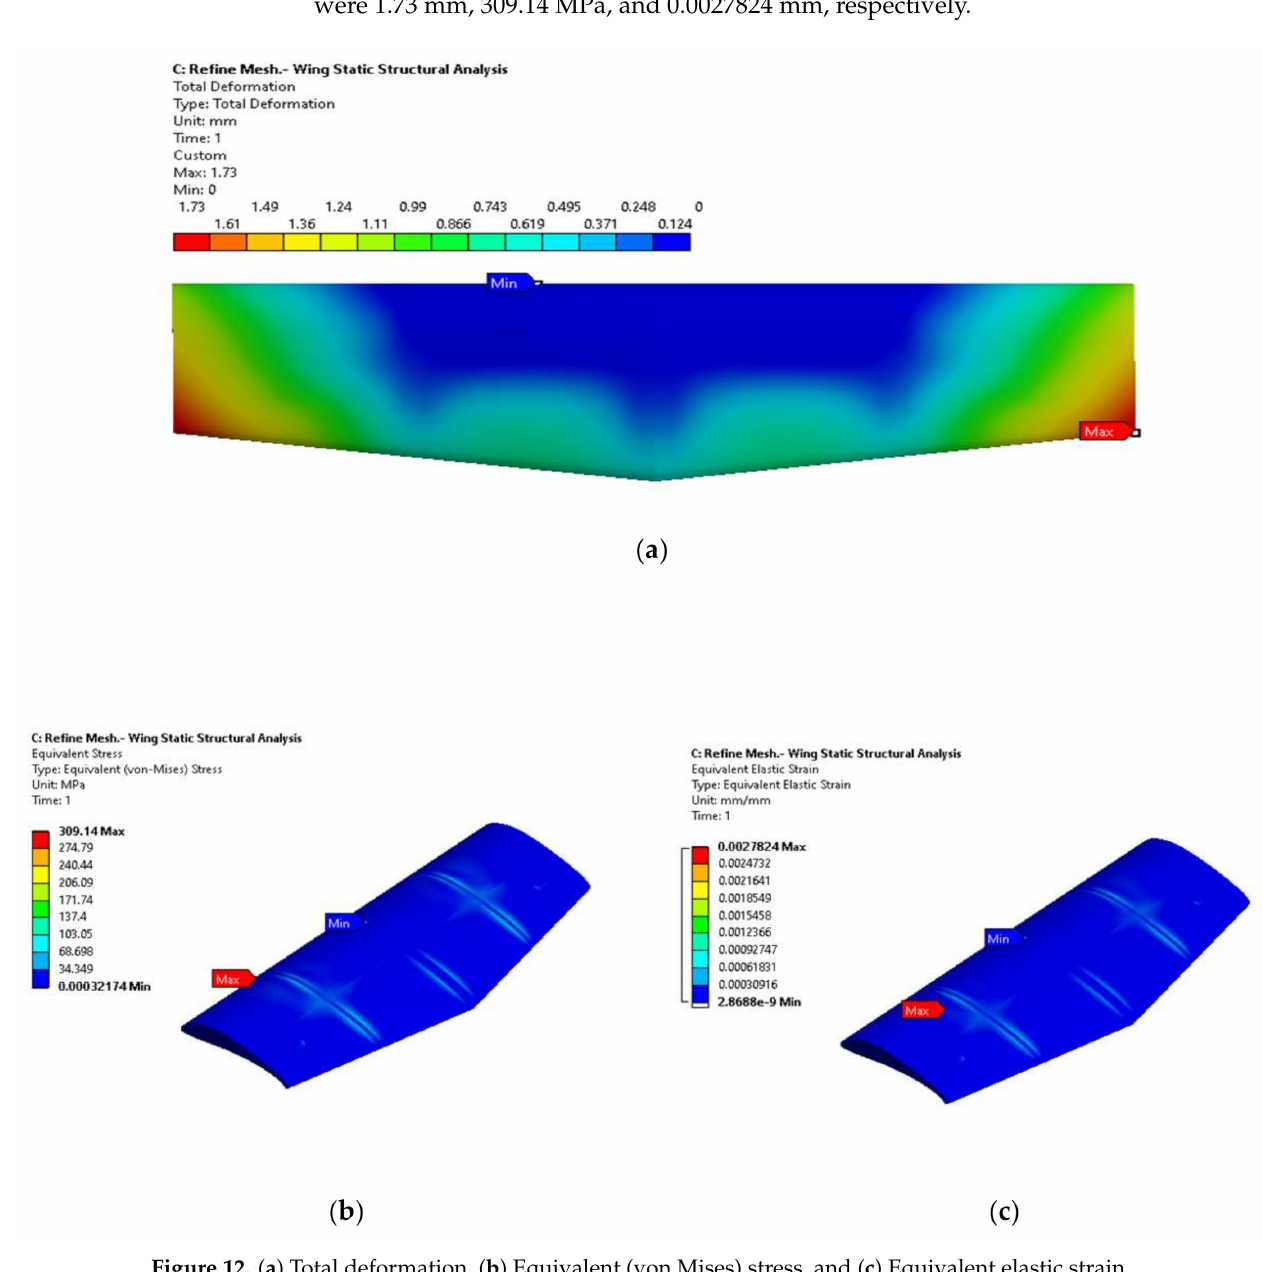
Figure 12. ( a ) Total deformation, ( b ) Equivalent (von Mises) stress, and ( c ) Equivalent elastic strain. Table 4. Maximum deformation, stress, and strain with and without inertia force